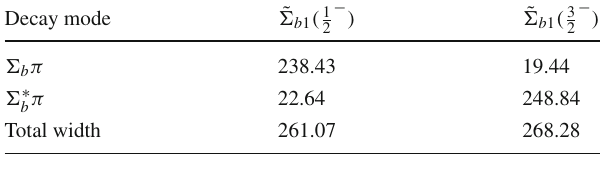
Table 6 Strong decays of the ˜ (cid:4) b ( 1 P ) states with the predicted masses in MeV Decay mode